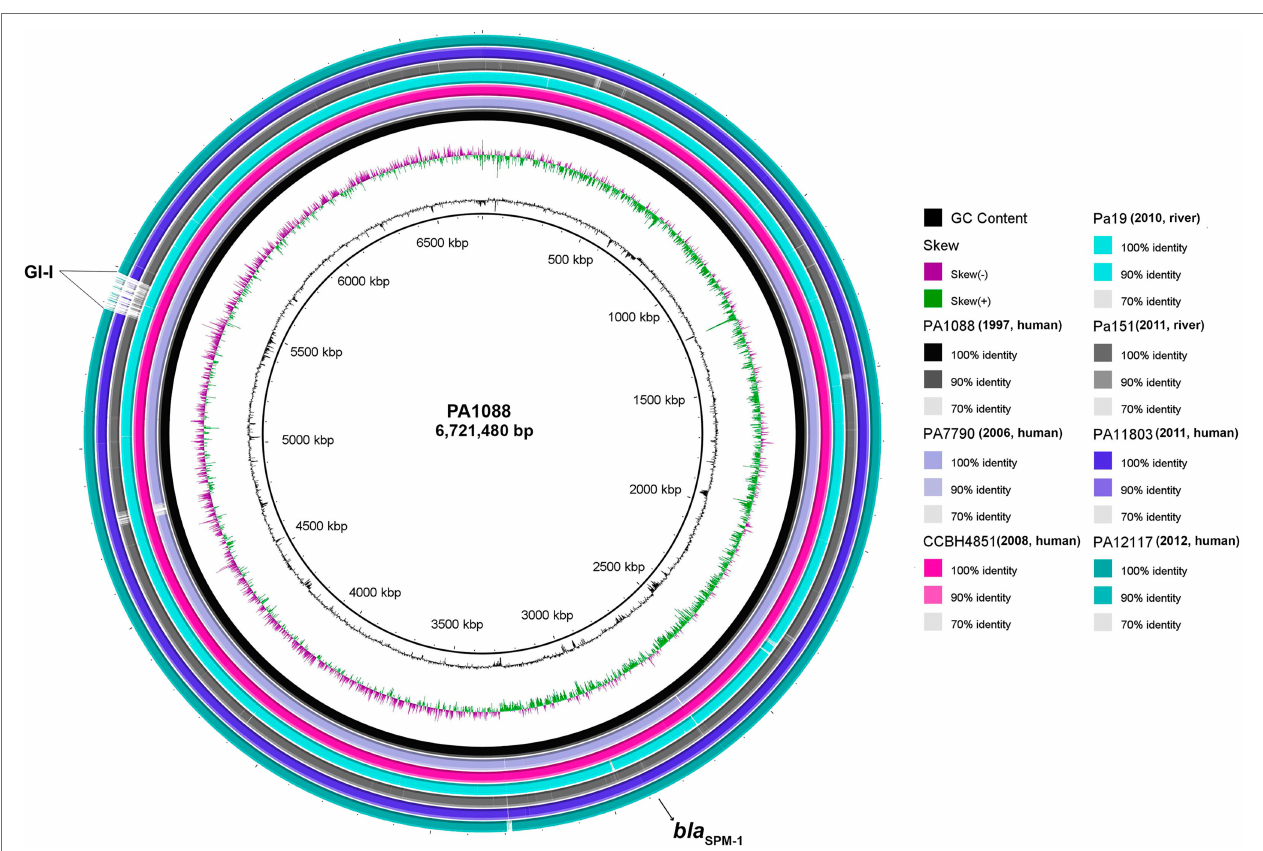
FIGURE 4 | Circular genome maps of SPM-1-producing P. aeruginosa belonging to ST277. Circular maps were built by BLAST Ring Image Generator (BRIG) using seven P. aeruginosa genomes. All genomes were represented as individual rings and compared against the reference genome PA1088 (GenBank accession number: CP015001.1). The bla SPM-1 gene is indicated by a black arrow. Furthermore, several genes associated with DNA replication/repair/regulatory/defense and membrane proteins were identified in the major genomic island, indicated as